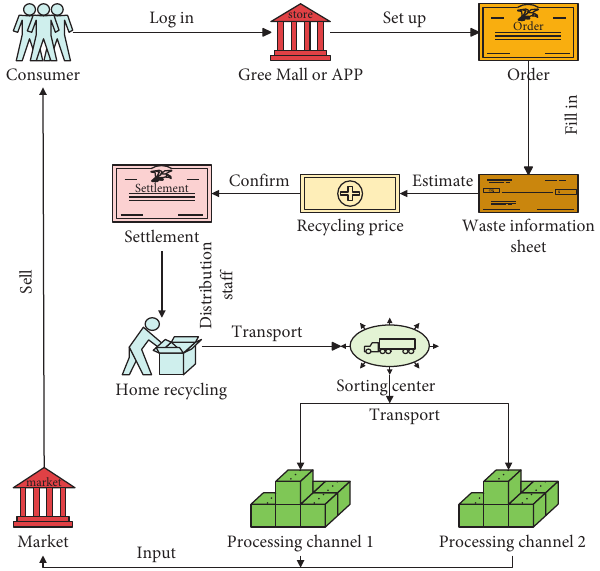
Figure 2: Flow chart of Gree’s new recycling